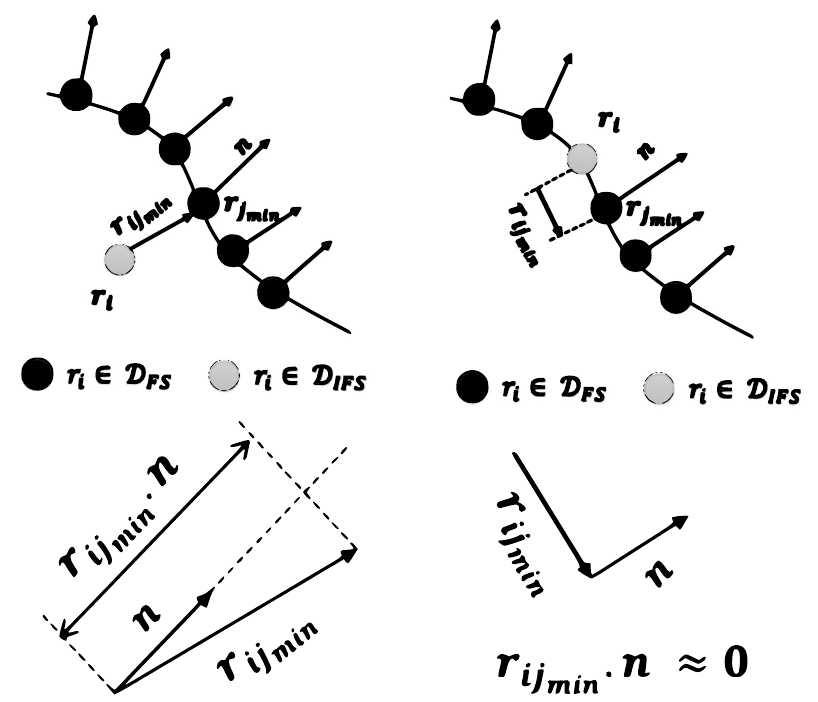
Figure 4. Different parameters used to define φ for particle i as r i ∈ D IFS